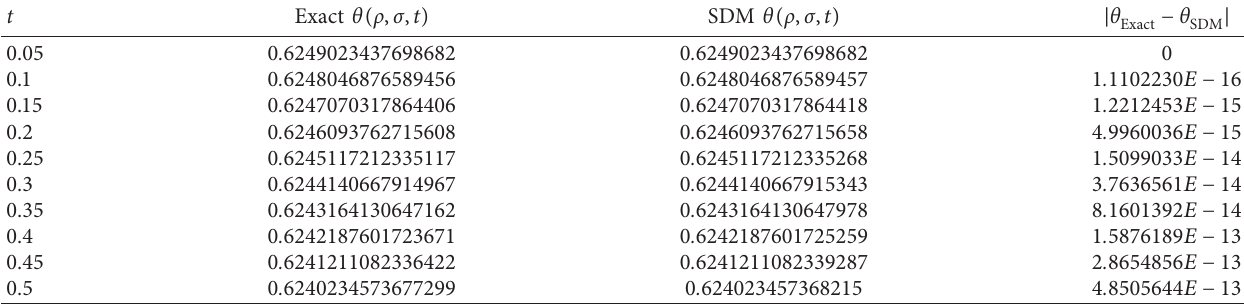
Table 1: The (SDM) results for θ ( ρ , σ , t ) for first four approximations for R � 1, with mesh points ρ � 0.1 and σ � 0.1, for Example 2.